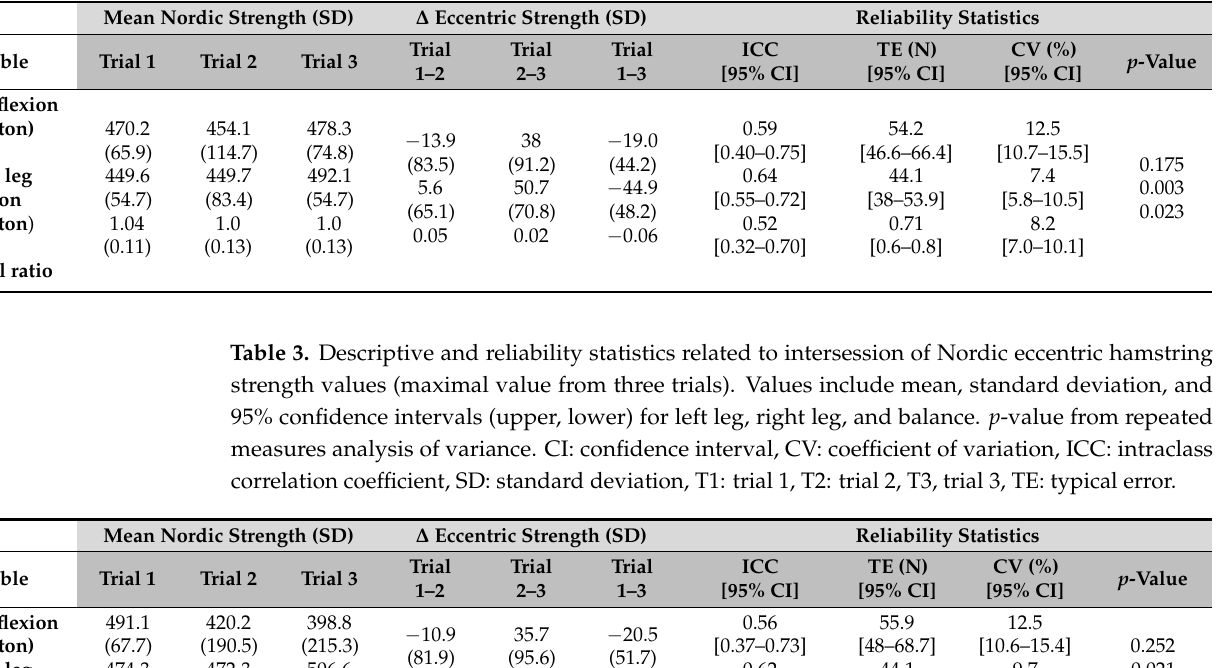
Table 2. Descriptive and reliability statistics related to intersession of Nordic eccentric hamstring strength values (mean of three trials). Values include mean, standard deviation, and 95% confidence intervals (upper, lower) for left leg, right leg, and balance examined. p -value from repeated measures analysis of variance. CI: confidence interval, CV: coefficient of variation, ICC: intraclass correlation coefficient, SD: standard deviation, T1: trial 1, T2: trial 2, T3, trial 3, TE: typical error.